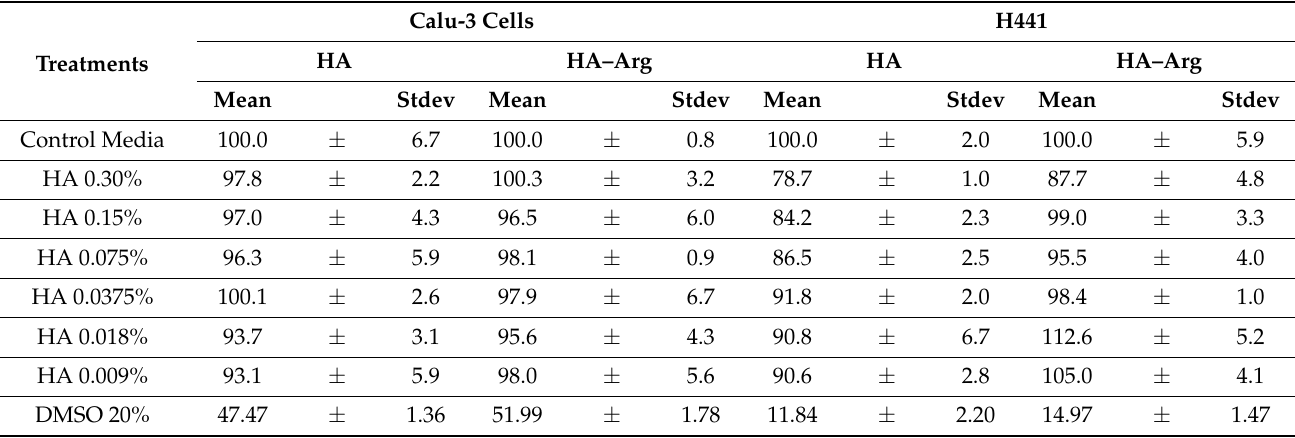
Table 2. Cytotoxicity of HA and HA–Arg on Calu-3 and H441 cell lines exposed to treatment for 24 h, expressed as mean cell viability ± Stdev ( n =